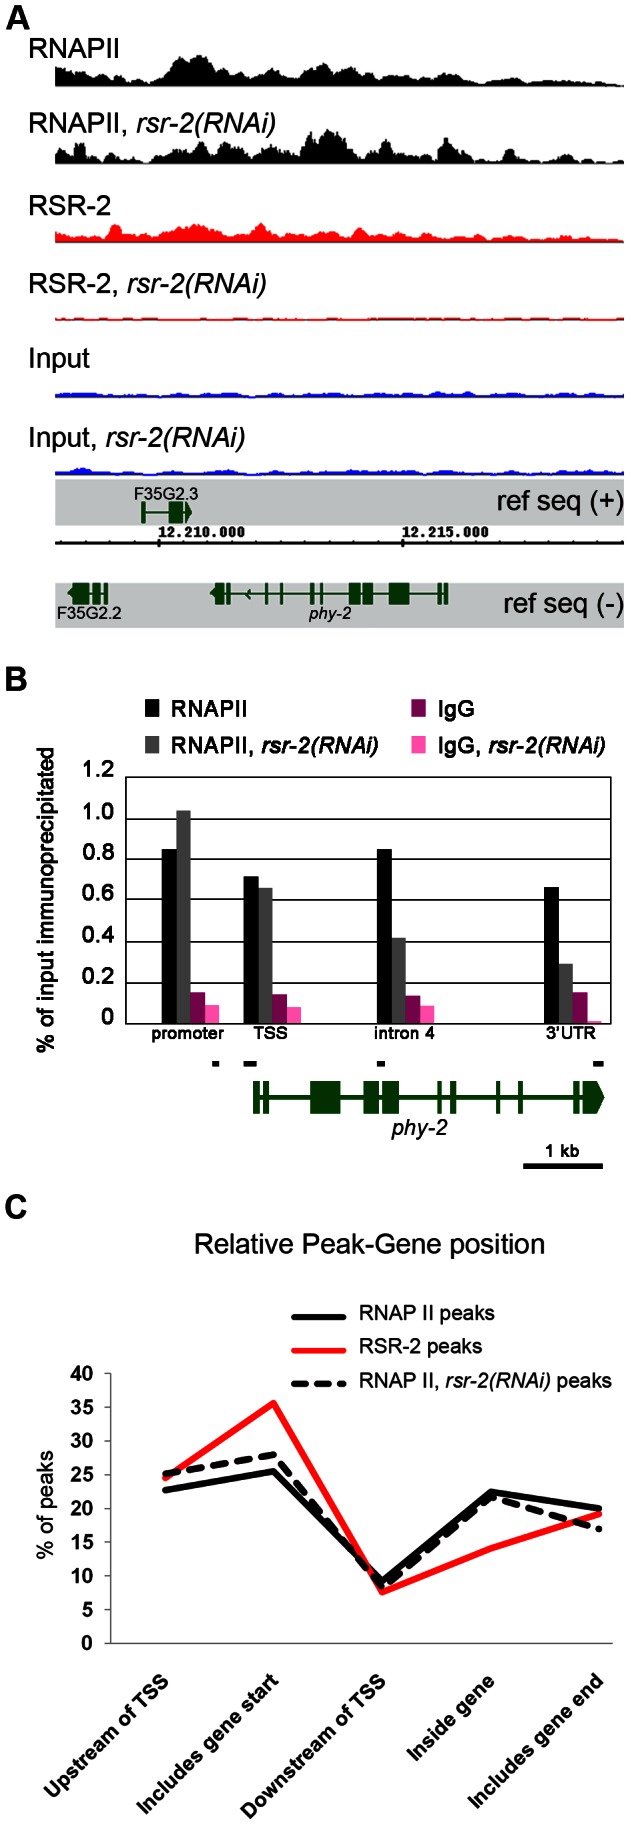
RSR-2 is associated with chromatin and modifies RNAPII distribution.(A) Snapshot of the genome browser (chromosome IV) showing ChIP-Seq data. Chromatin-binding profiles of RNAPII and RSR-2 are similar. RNAPII peaks are represented in black, RSR-2 peaks are represented in red, and input samples are represented in blue. Upon rsr-2 RNAi, the RNAPII peak profile at phy-2 locus shifts from the 3′ to the 5′end. RSR-2 peaks disappear upon rsr-2 RNAi. Data was visualized with the Integrated Genome Browser (IGB) software. (B) ChIP-qPCR showing how RNAPII occupancy changes upon rsr-2 RNAi at the phy-2 locus. Black bars are a scaled representation of the regions covered by the primer pairs used in this experiment. (C) Distribution of RNAPII and RSR-2 ChIP peaks along five zones within an averaged gene. Statistically called peaks from a single ChIP-Seq experiment were classified with respect to their position relative to the nearest TSS. Y axis indicates the frequency of peaks within each zone. rsr-2 RNAi slightly modifies the distribution of RNAPII along an averaged gene.